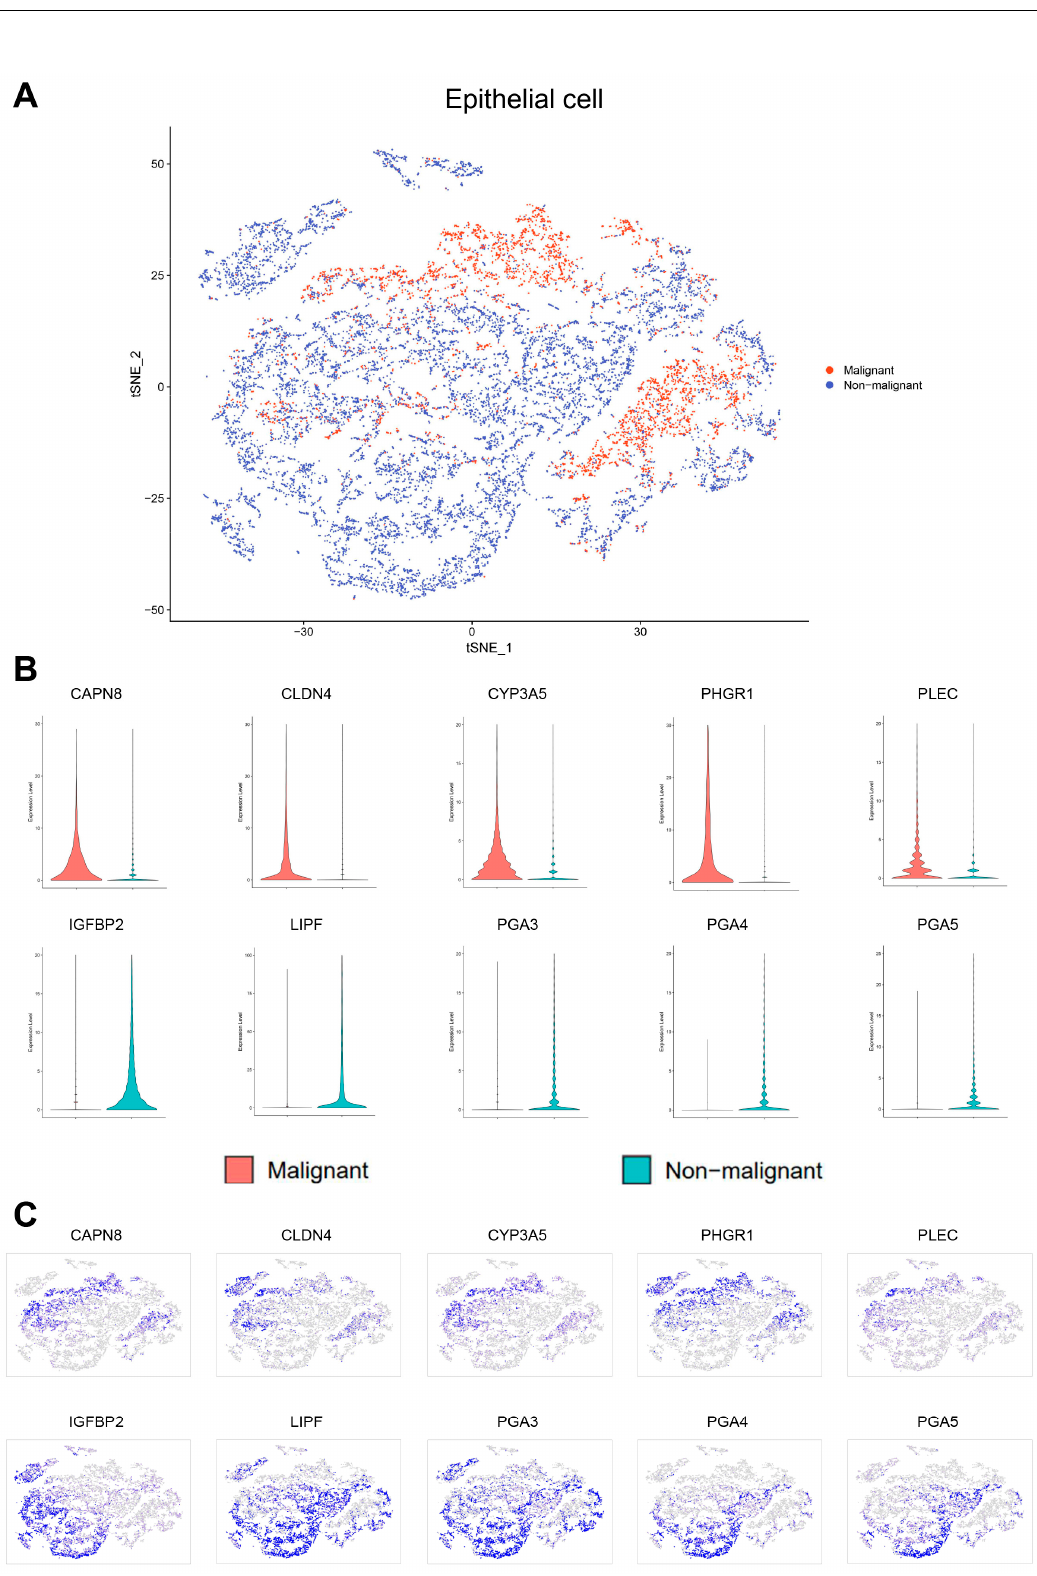
Figure 4. Classification of the epithelial cells as malignant or non-malignant. ( A ) tSNE plot showing the classification of malignant and non-malignant cells. ( B ) Violin plots showing the expression of ten representative genes with differential expression between malignant and non-malignant cells. ( C ) tSNE plots showing the expression of ten representative genes with differential